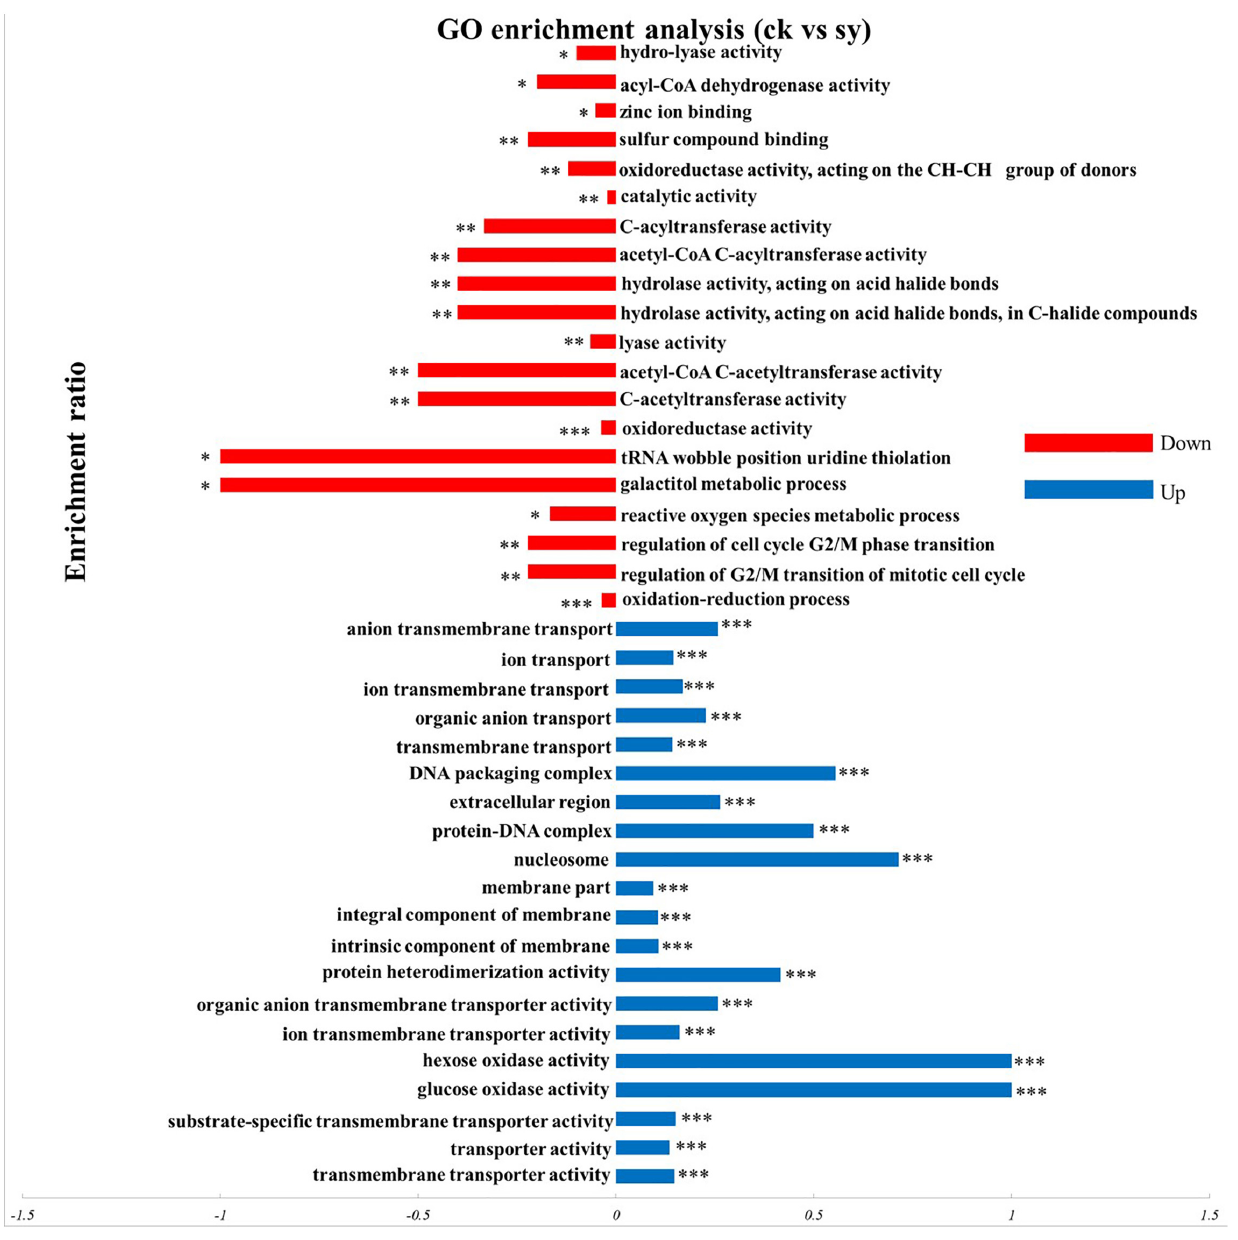
result indicated that incubation of the X33 antifungal extract induced the oxidative stress in P. digitatum